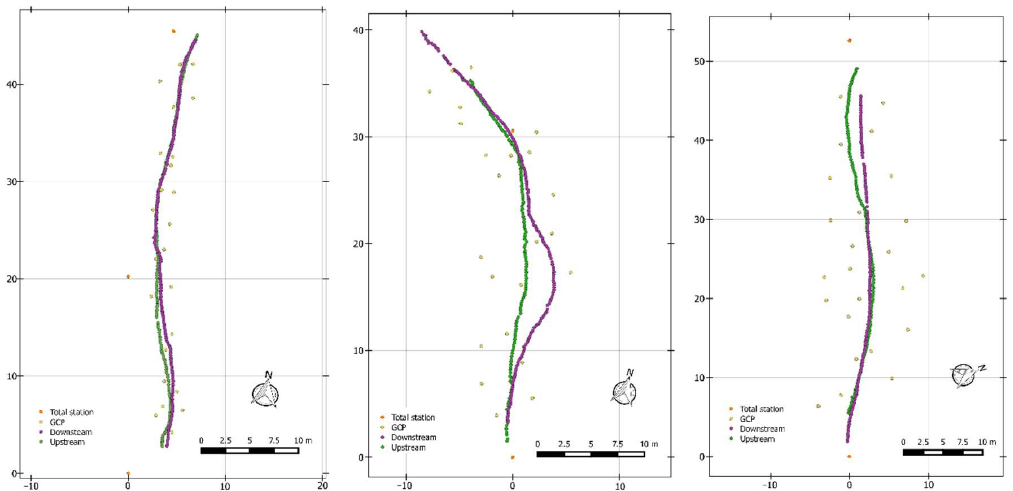
Figure 4. Data collection set up for each of the 40 m reaches surveyed: ( a ) Chicheley Brook (Cranfield, UK); ( b ) River Ouzel (Ouzel Valley Park, UK); and ( c ) River Great Ouse (Wolverton, UK). GCP stands for Ground Control Point. Downstream and Upstream indicate the locations where images were collected when walking the reach in the stated direction. The coordinates are local.